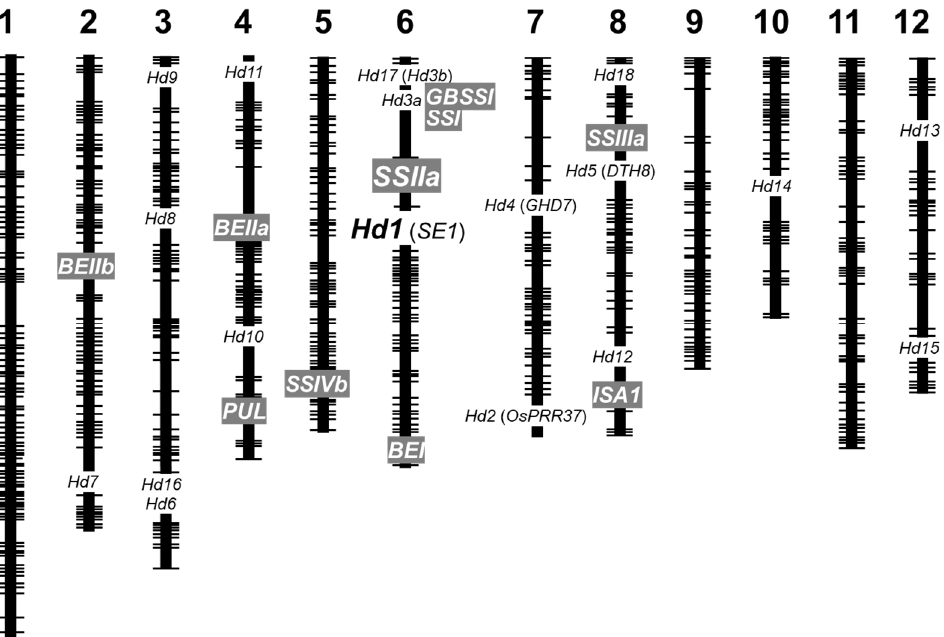
Figure 1. Chromosomal locations of genes responsible for the regulation of heading date and endosperm starch biosynthesis in rice. Genes controlling heading date are written in black writing ( Hd1 is enlarged) and those involved in starch biosynthesis in the rice endosperm are highlighted in gray. Note that Hd1 and SSIIa are located in close proximity of each other on chromosome 6.